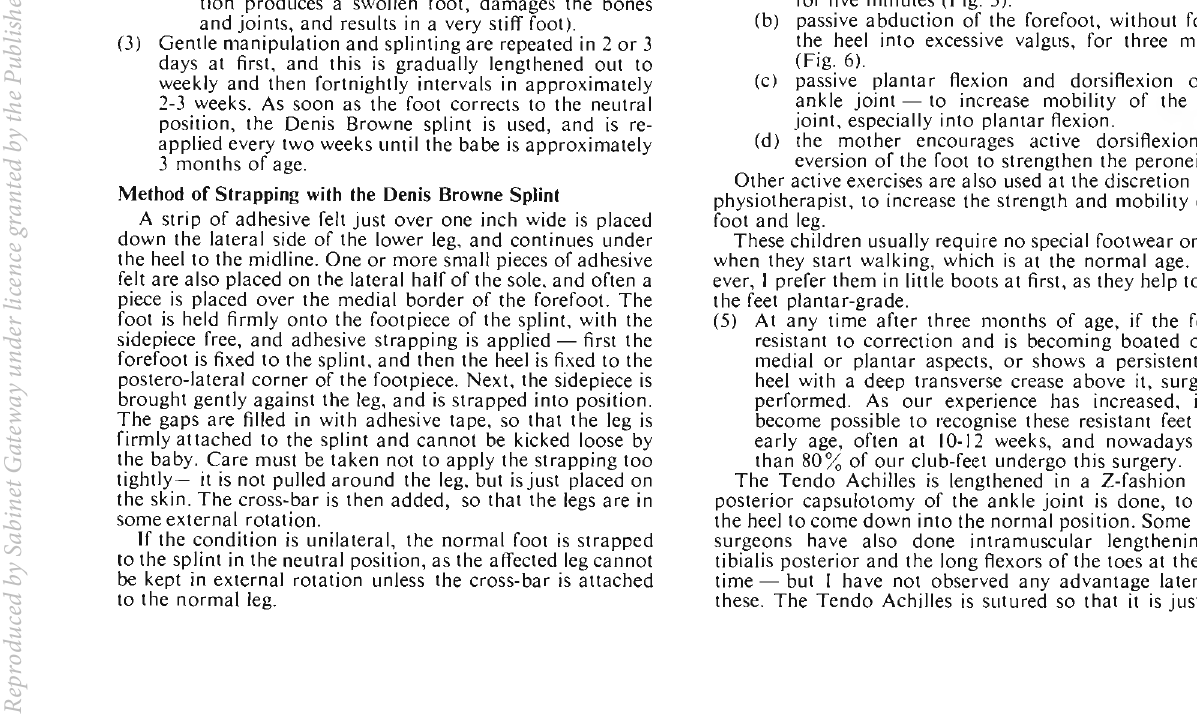
Fig. 3: Feet strapped onto a Denis Browne hobble